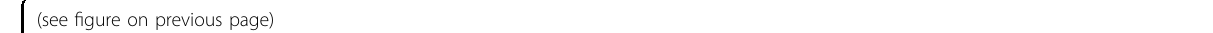
Fig. 3 Knockdown of SMYD2 results in a decrease in tumor growth and metastasis in vitro and in vivo. A Knockdown ef fi ciency of SMYD2 in SPC-A1 and GLC-82 cells were con fi rmed through western blotting, with GAPDH as an internal control. B , C SMYD2 knockdown inhibited both SPC- A1 and GLC-82 cells proliferation as detected by CCK8 proliferation assay and colony formation assay. * p < 0.05; ** p < 0.01; *** p < 0.001; **** p < 0.0001 compared with the control from two-way ANOVA comparisons test. D SMYD2 knockdown markedly attenuated cell migration and invasion in SPC- A1 and GLC-82 cells measured by wound healing and Transwell assays. The images represent one fi eld under the microscope (×200 magni fi cation). **** p < 0.0001 compared with unpaired T test. Scale bars, 100 μ m. E , F The in vivo xenograft model showed that SMYD2 knockdown (shSMYD2) reduced tumor volume and weight compared with the shSCR control group. G The vivo metastatic model showed that SMYD2 knockdown group could reduce the metastatic lesion than those in the control group. Two-way ANOVA comparisons test was performed on tumor volume. Unpaired T test was performed on tumor weight, *** p < 0.001, **** p <